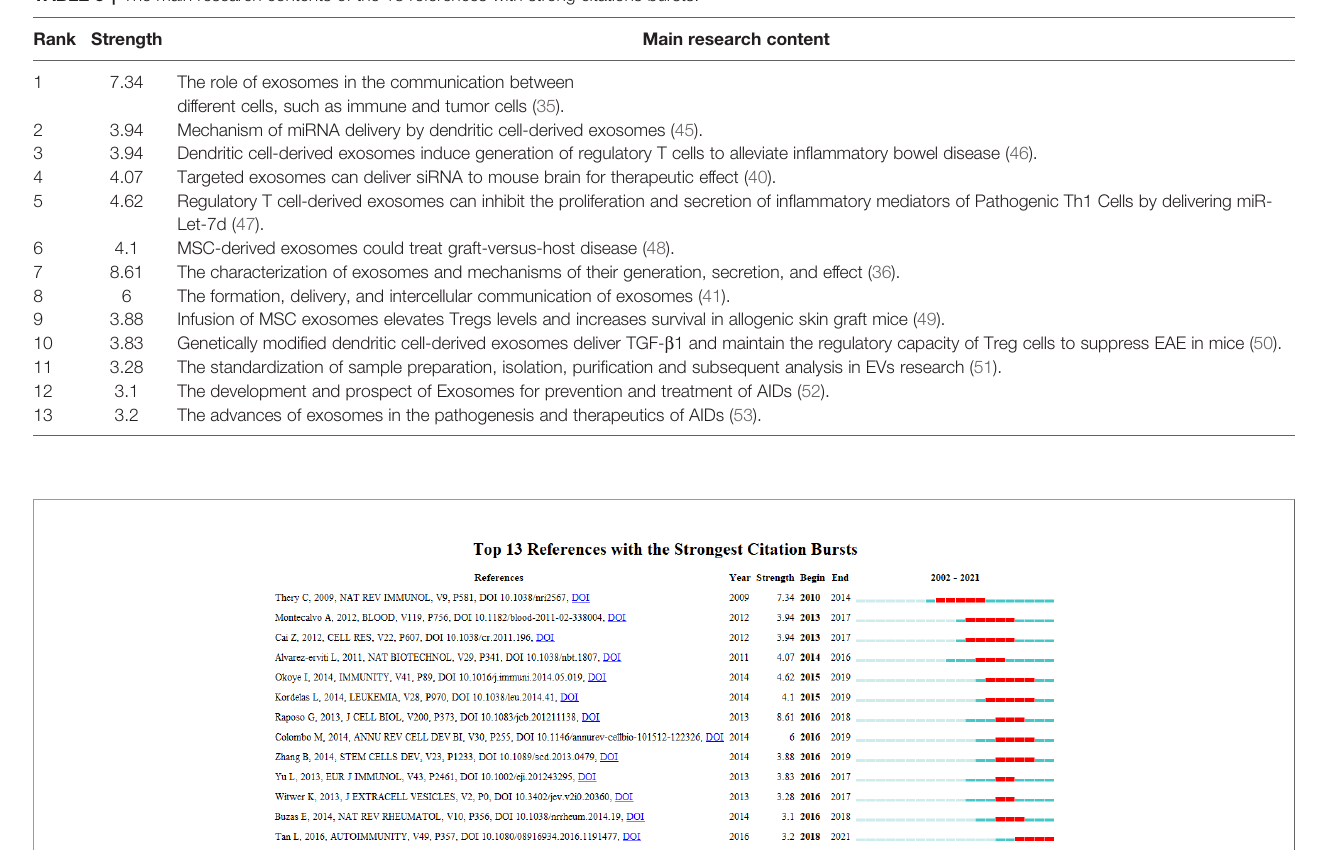
TABLE 5 | The main research contents of the 13 references with strong citations